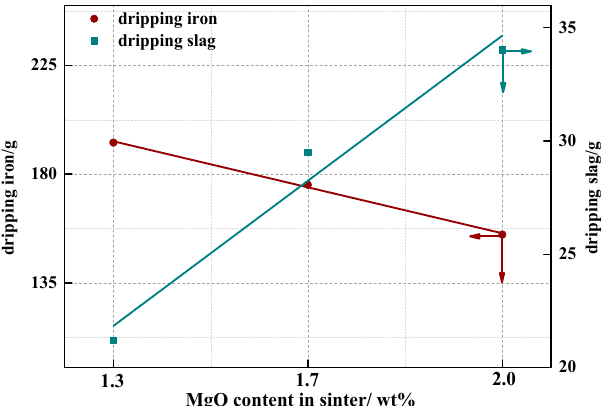
Figure 9. Changes of softening and melting of sinters with different MgO content.